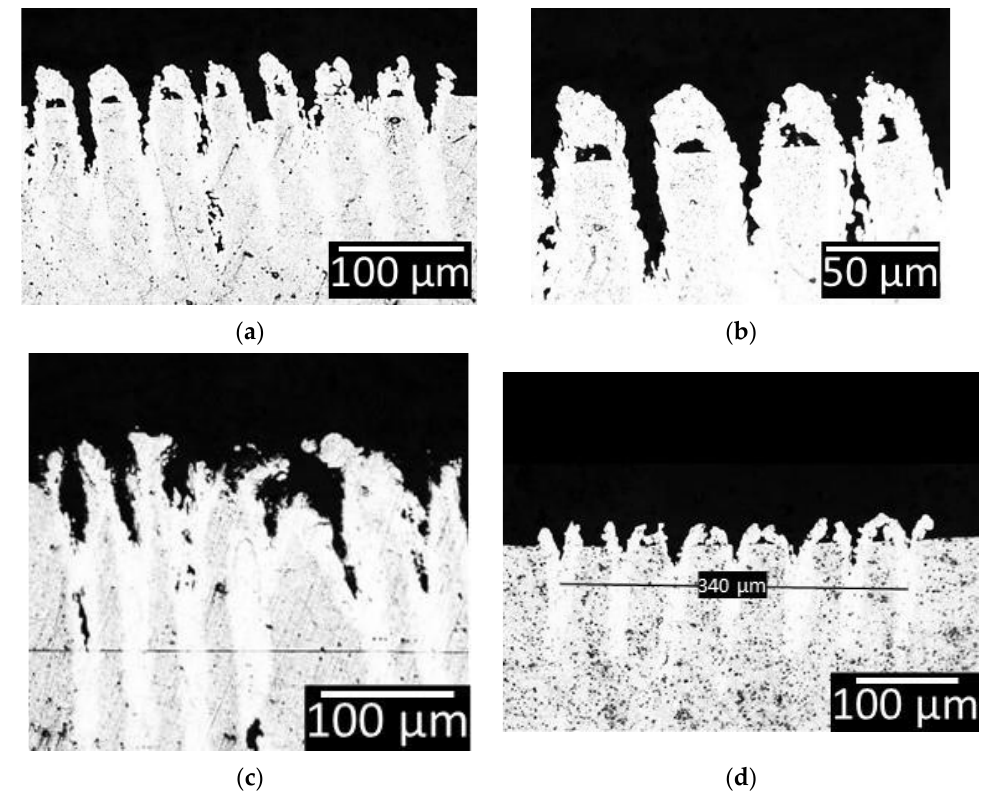
Figure 11. Microscopic observation of the engravement at the density of 25% and a speed of 100 mm/s ( a ); zoom on the teeth ( b ); at a higher density of 35% and a low speed of 5 mm/s ( c ); high-speed 200 mm/s and low density of 15% ( d ).